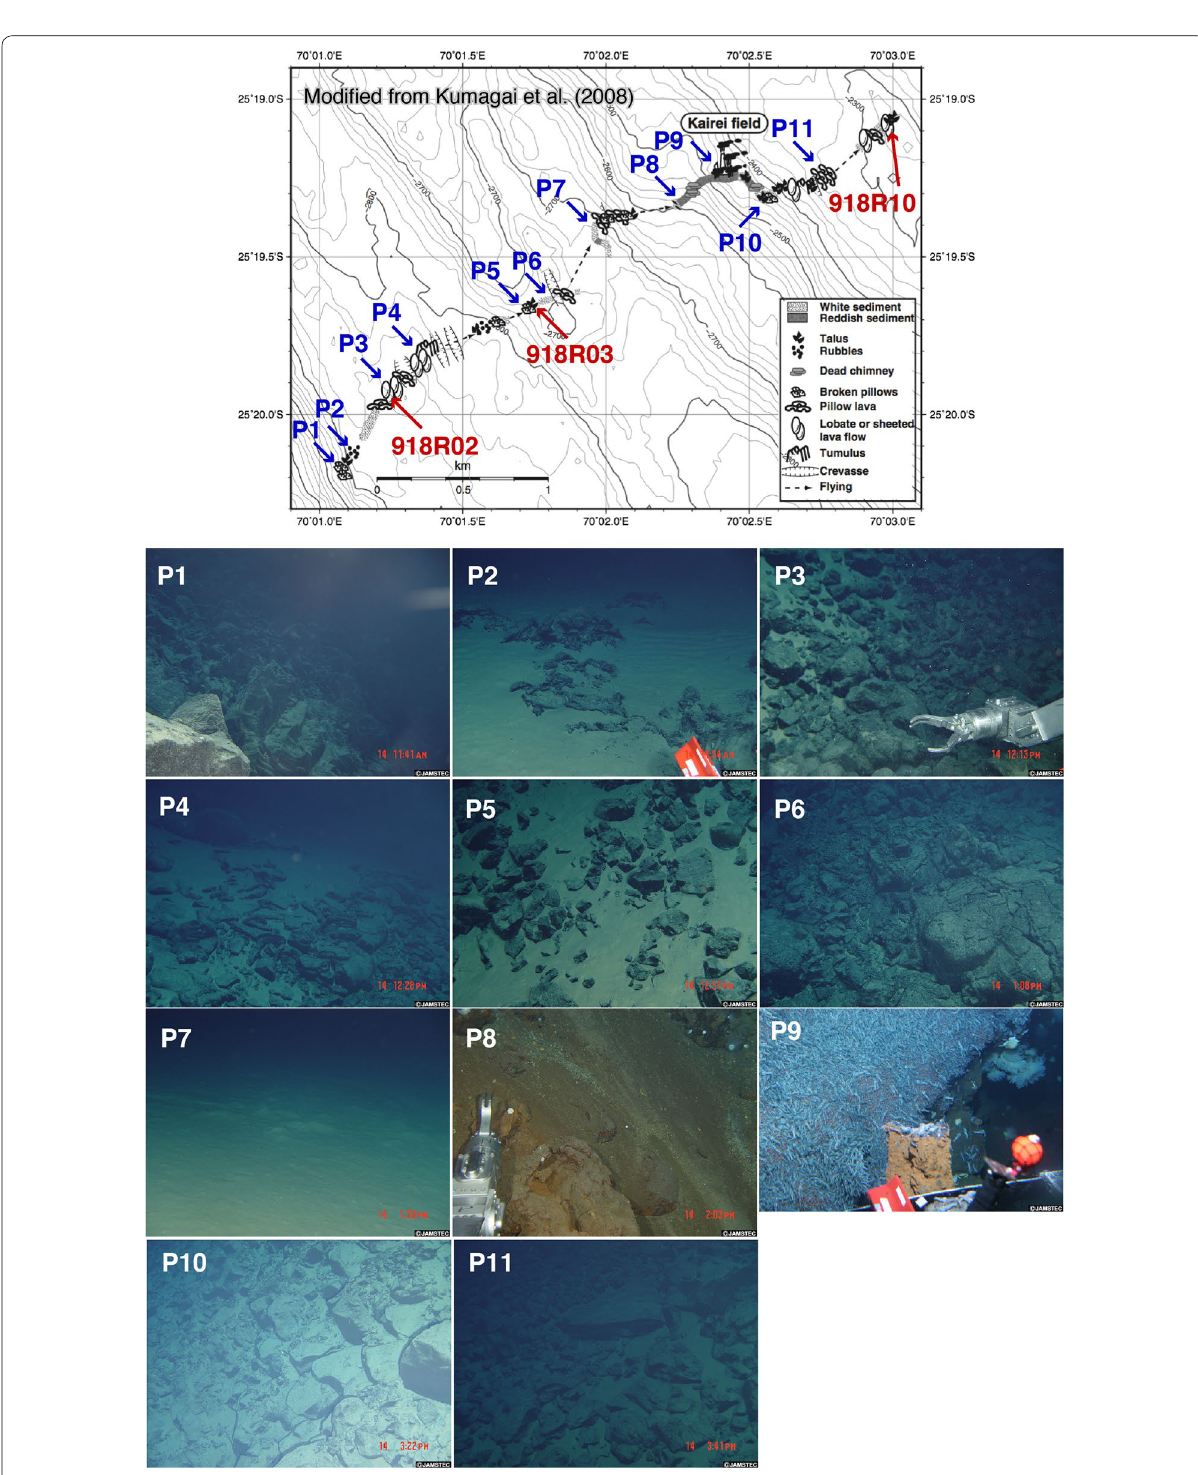
Fig. 4 Seafloor surface geological signatures along the dive track of 6K#918 modified from Kumagai et al. (2008) (dive observer: H. Kumagai). Major element composition for lava samples of 918R02, 918R02, and 918R10 is shown in Additional file 5: Table S1 and Additional file 3: Figure S3. Photo data are cited from Data and Sample Research System for Whole Cruise Information “ DARWIN ” managed by JAMSTEC (http://www.godac .jamst ec.go. jp/darwi